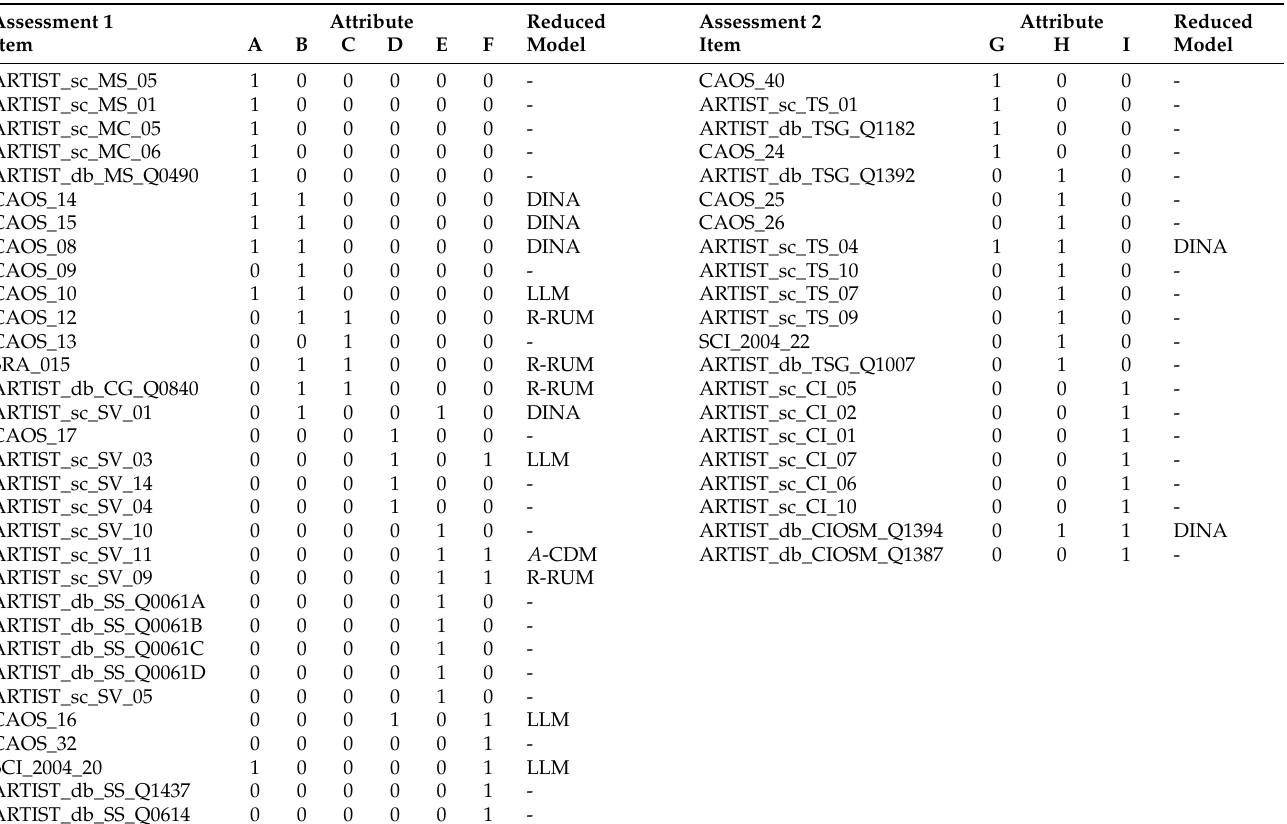
Table 3. Final Q-matrices and selected reduced DCMs per